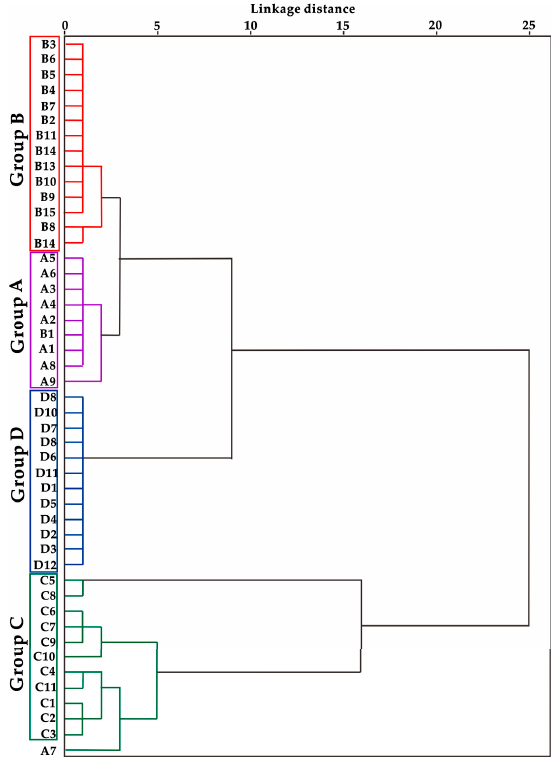
Figure 2. Dendrogram from the Q-cluster analysis of all water samples.